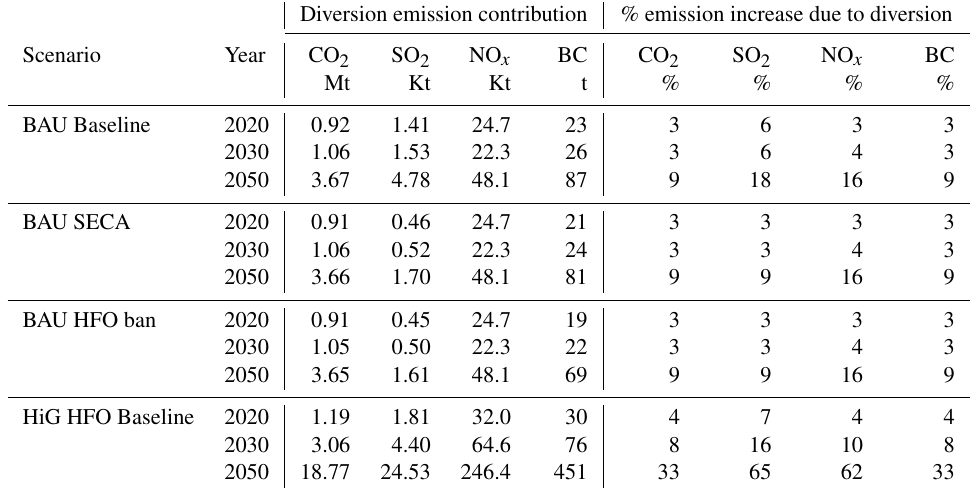
Table 2. Estimated emissions of CO 2 , SO 2 , NO x and BC for the polar diversion routes in domain d03 in 2020, 2030 and 2050. Diversion emission contribution % emission increase due to